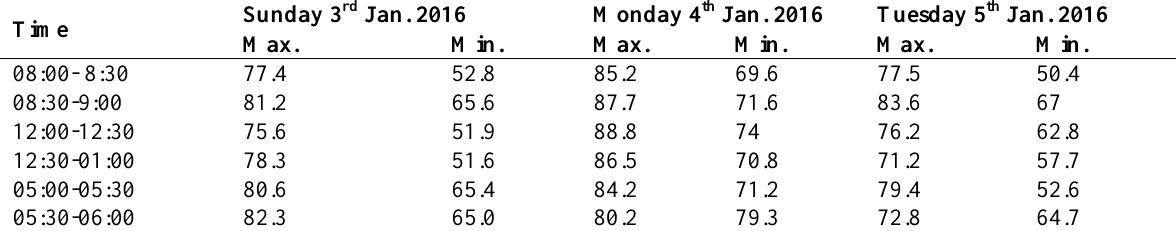
Noise levels in dB(A) at governorate site